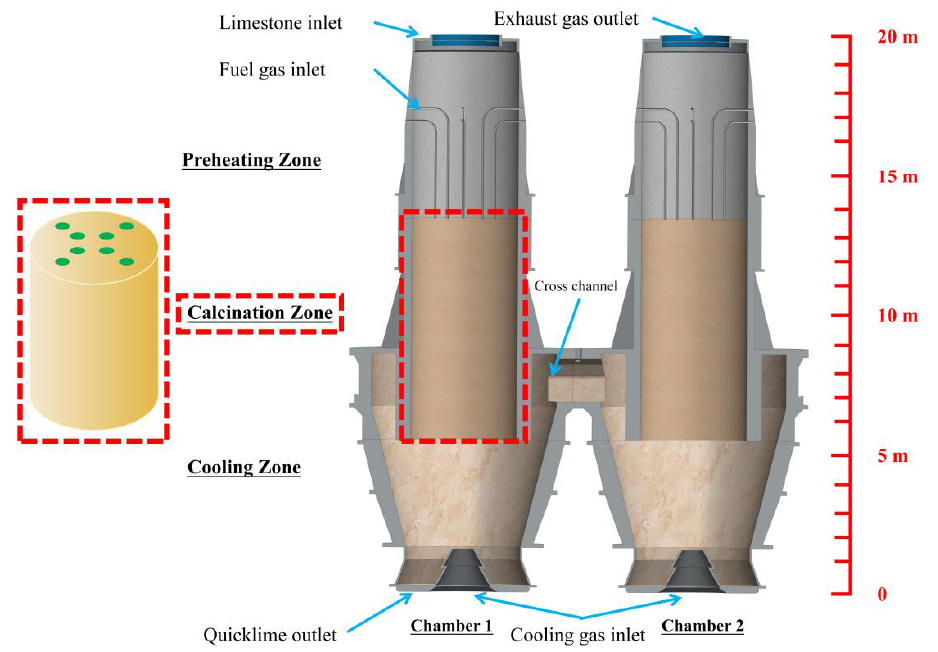
Figure 1. Features of PFR lime kiln composition and the calcination zone.